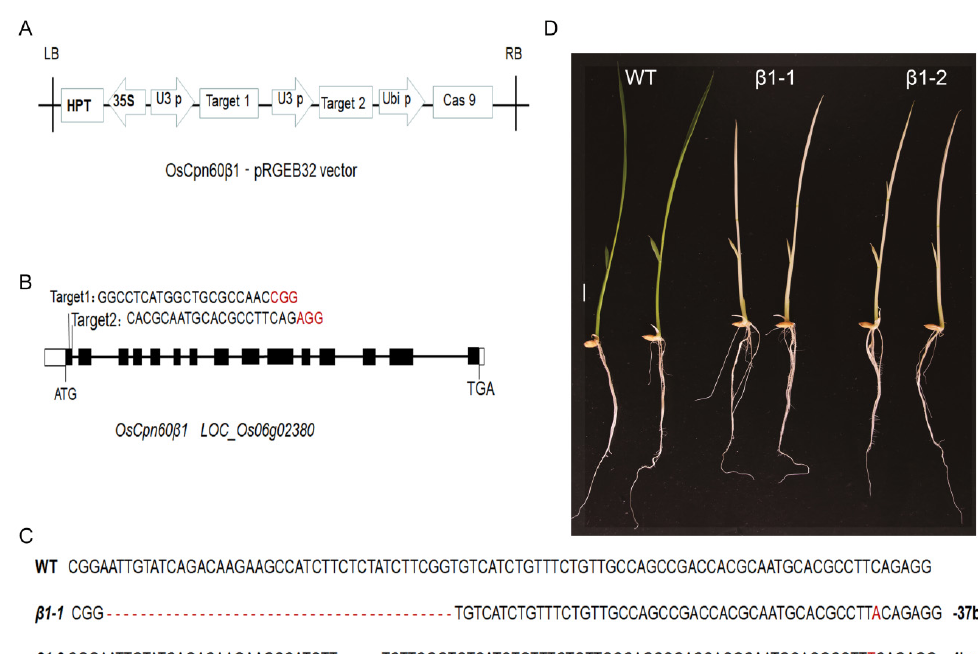
Figure 1. Production of OsCpn60 β 1 knockout mutants via the CRISPR / Cas9 system. ( A ) Diagram of CRISPR / Cas9 system for editing OsCpn60 β 1 . ( B ) Schematic diagram of targets sites in OsCpn60 β 1 . Black boxes show exons, black lines show introns and white boxes show untranslated regions (UTR).